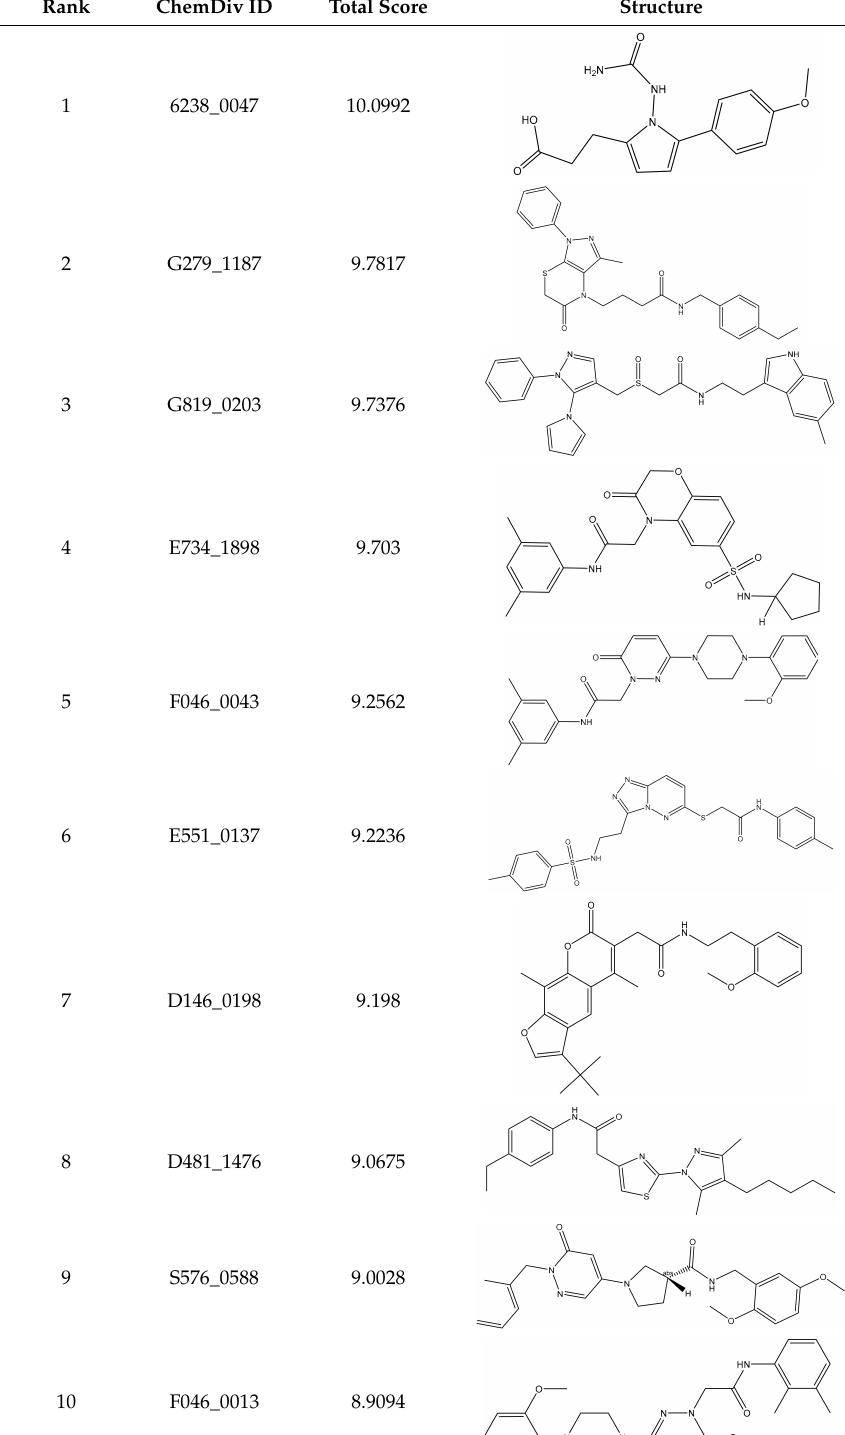
Table 1. The docking scores for top 11–20 compounds are provided in Supplementary Table S1. Table 1. Docking score and chemical formula of top 10 candidate